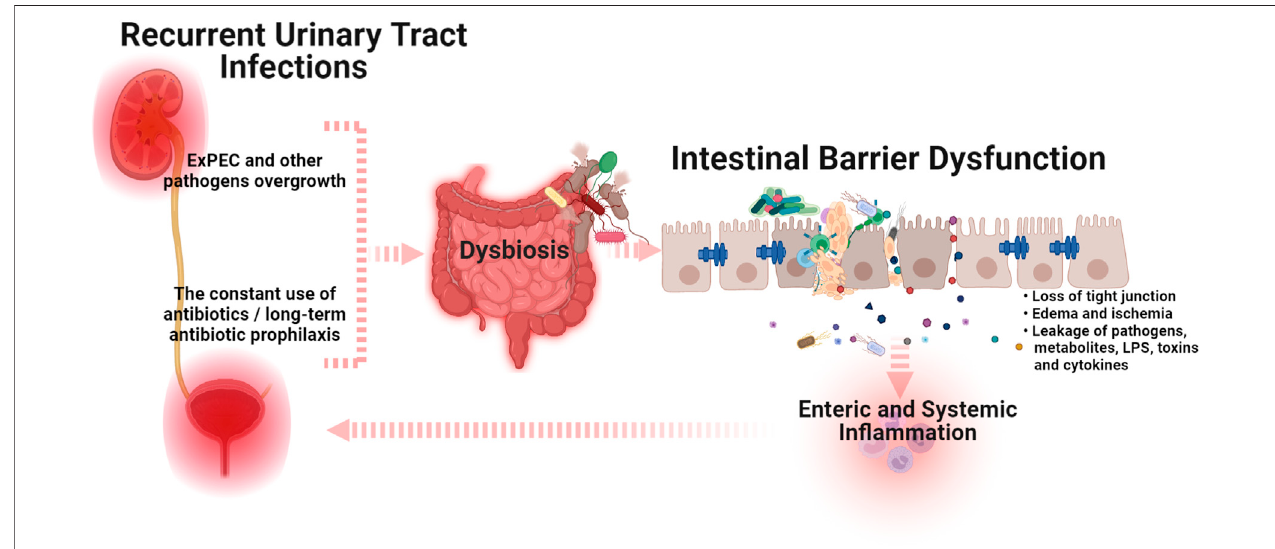
FIGURE 1 | A schematic illustration of the cross-talk between intestinal barrier dysfunction and recurrent urinary tract infections (Graphic created by BioRender. com). The overgrowth of extraintestinal pathogenic E. coli (ExPEC) and/or the use of antibiotics that induce dysbiosis can trigger intestinal barrier dysfunction, which causes enteric and systemic in fl ammation. In turn, the impaired intestinal barrier is the main source of the constant persistence of ExPEC in the urinary tract and a consequent predisposition for RUTIs. Abbreviations: ExPEC, extraintestinal pathogenic E. coli ; LPS,